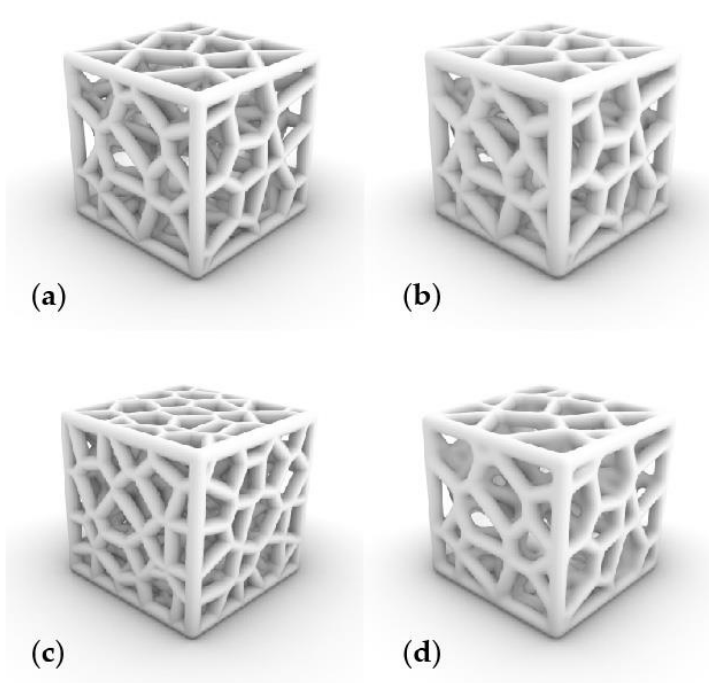
Figure 8. Four examples of Voronoi models with different sets of parameters: ( a ) the baseline model (Model A) with a node count of 60, rod radius 1.8 mm and smoothness width 1; ( b ) rod radius is changed to 2.4 mm in Model B; ( c ) node count parameter is raised to 120 in Model C while the rest are the same as for the baseline one; ( d ) smoothness width is set to 6 in Model D with the rest unchanged. Model A has XYZ dimensions of 40 × 40 × 40 mm 3 , a node count of 60, a curve radius of 1.8 mm and a smoothness width scale of 1. In Model B, the curve radius was changed